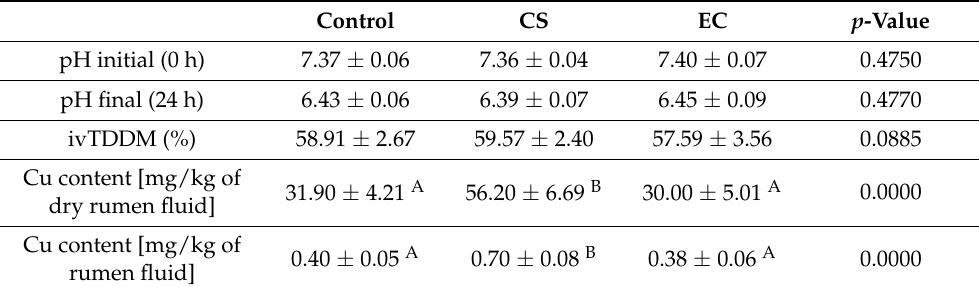
Table 2. Effects of copper sulphate (CS) and encapsulated copper (EC) addition after 24 h of rumen fermentation ( in vitro ).